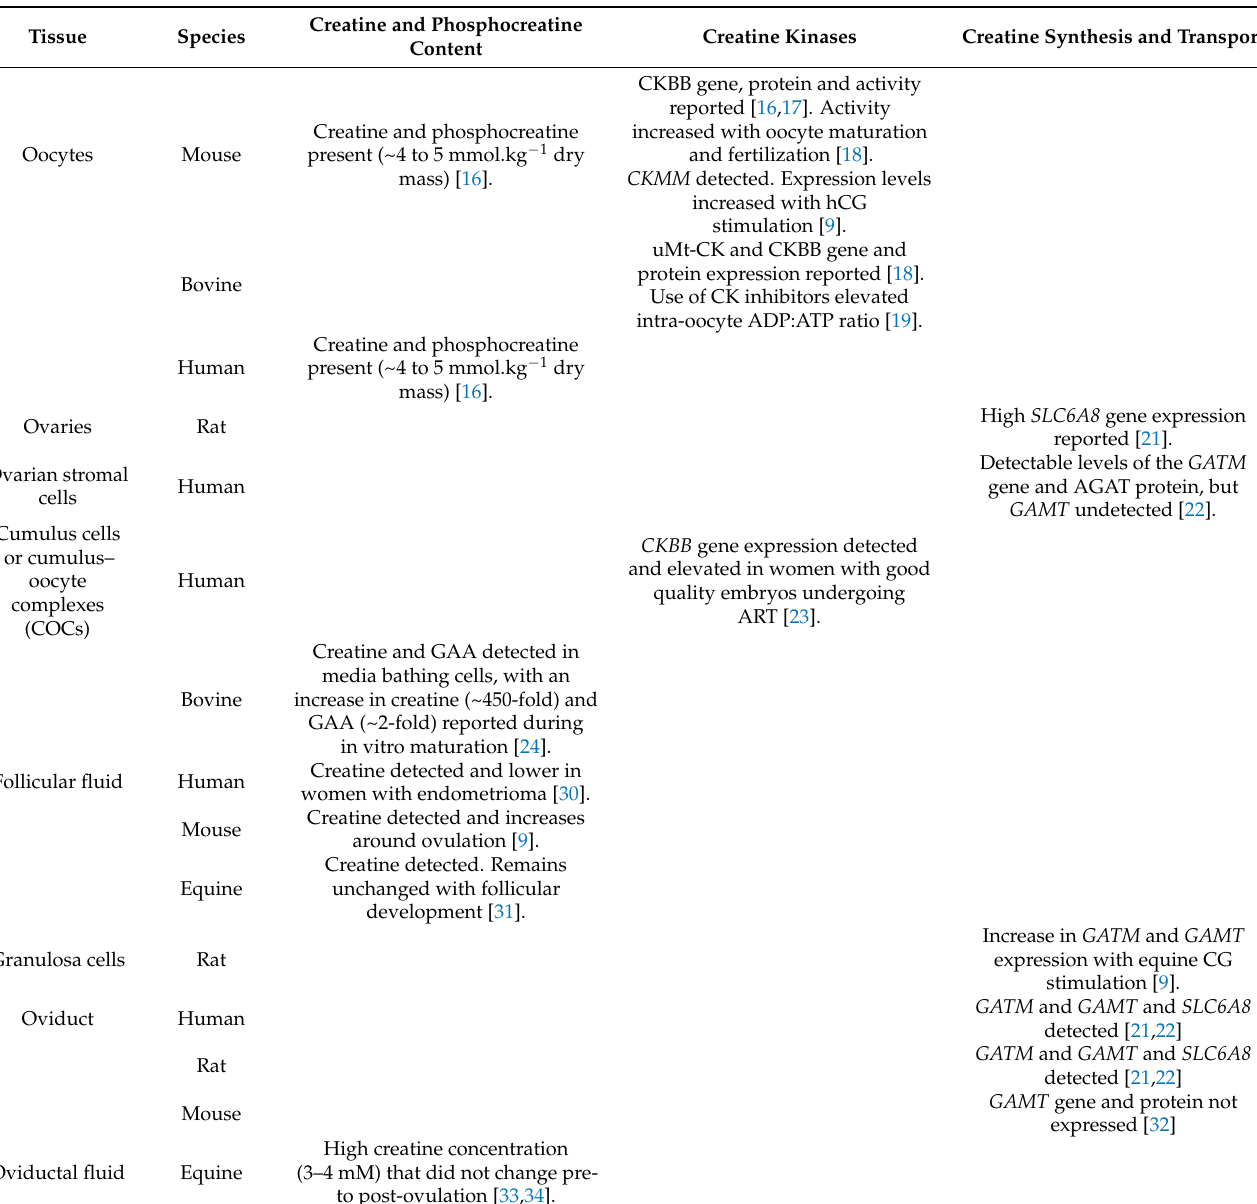
Table 1. Summary of creatine metabolism in the female reproductive